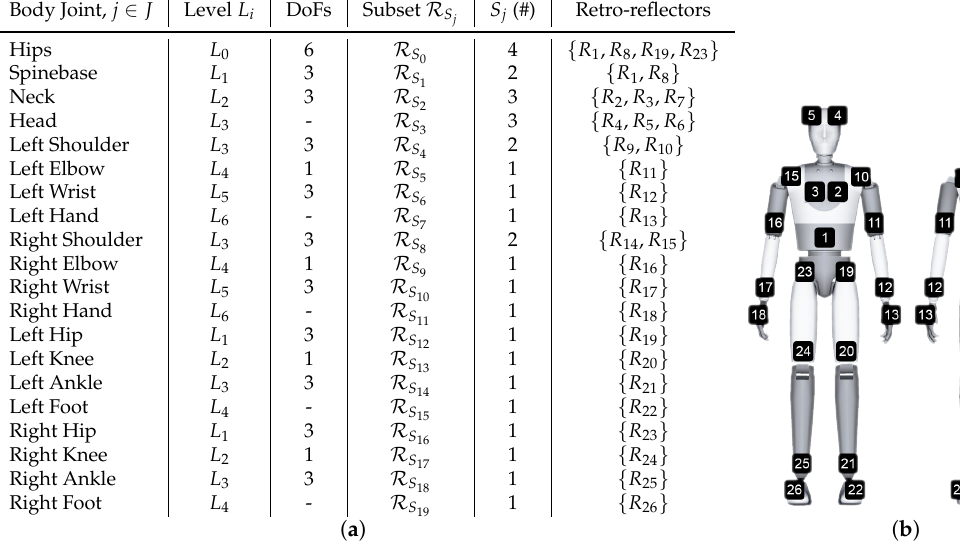
Figure 9. ( a ) Template model joints, hierarchical level, DoFs and correspondence to the reflector subsets. ( b ) Reflector mapping to body structure body